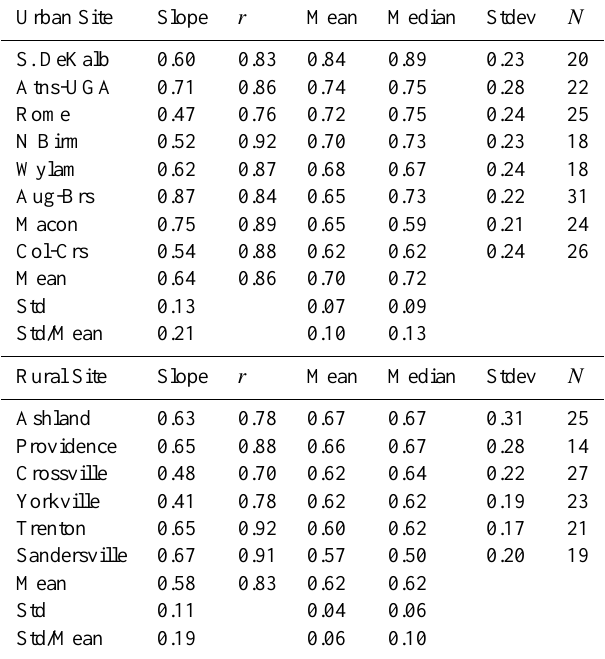
Table 2a. Summary of Abs 365 to WSOC regression slopes and ra- tios in units of m 2 gC − 1 (i.e., mass absorption efficiency) for each 24-h FRM filter site. Data from Long Creek are excluded due to spurious Abs 365 measurements and regressions with low r (Atns- UGA r =0.33) are not included in the statistical calculations. For each site classification (Urban or Rural) Sites are in descending or- der of Mean Abs 365 /WSOC. N is the number of data points (filters).